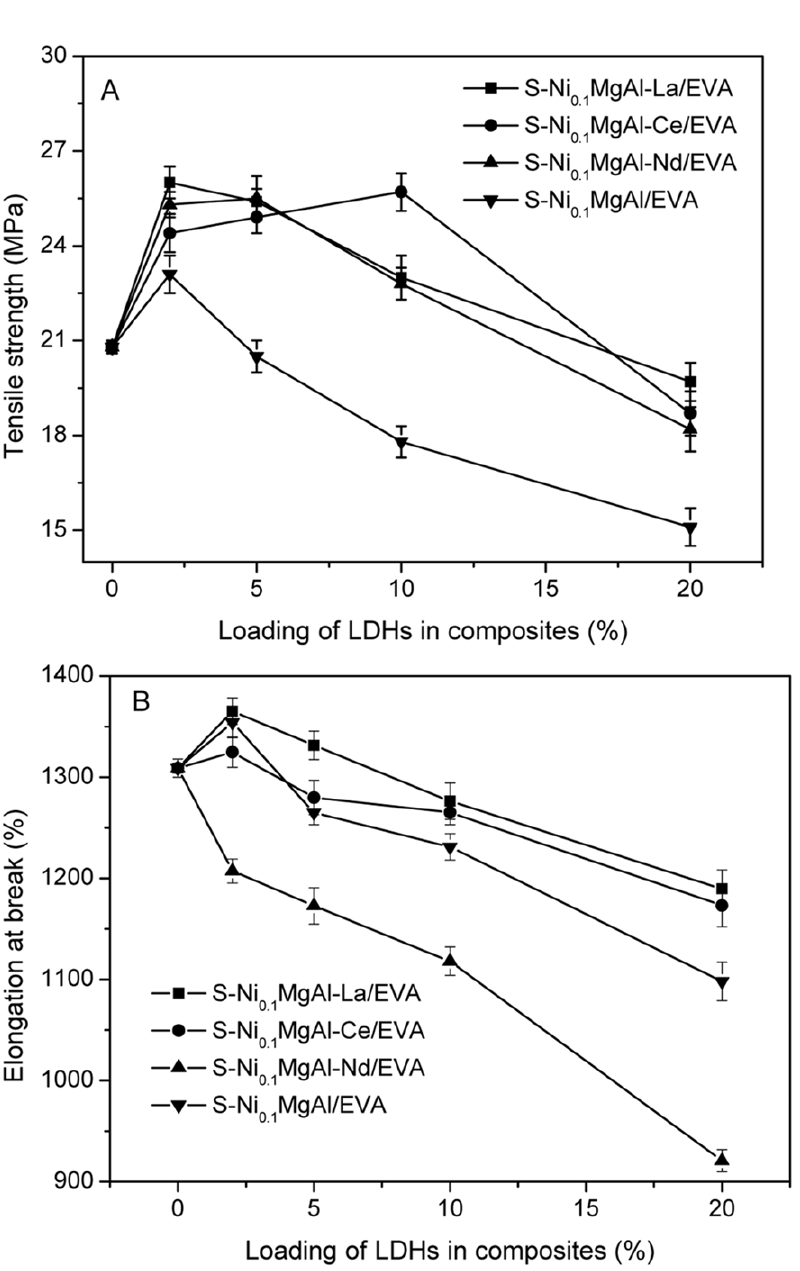
Figure 10. Tensile strength and the elongation at break of composites with different contents of LDHs. A: Tensile strength curves and B: Elongation at break